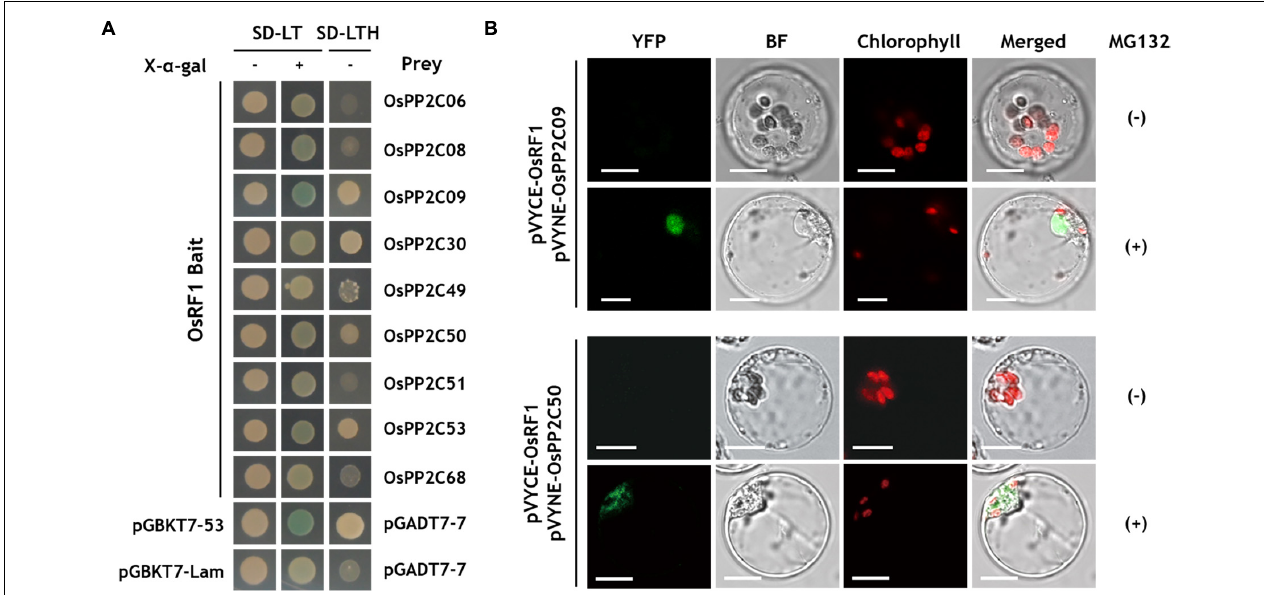
FIGURE 5 | OsRF1 interacts with clade A OsPP2Cs. (A) Yeast two hybrid (Y2H) assay. AH109 yeast cells were co-transformed with the bait (pGBKT7-OsRF1) and prey (pGADT7-OsPP2Cs) constructs. Transformed cells were plated in color change selection media (SD-LT/X- α -Gal) or growth selection media (SD-LTH) and grown at 30 ◦ C for 3 days. (B) BiFC assay using pVYCE-OsRF1 and pVYNE-OsPP2Cs in rice protoplasts. The rice protoplast co-expressing OsRF1-VYCE and OsPP2C09-VYNE or OsPP2C50-VYNE in the presence or absence of MG132 was visualized using a confocal laser scanning microscope. YFP signals are represented in green, and chloroplast auto-fluorescence is represented in red. YFP; yellow fluorescent protein; BF, bright field. Bar = 10 µ